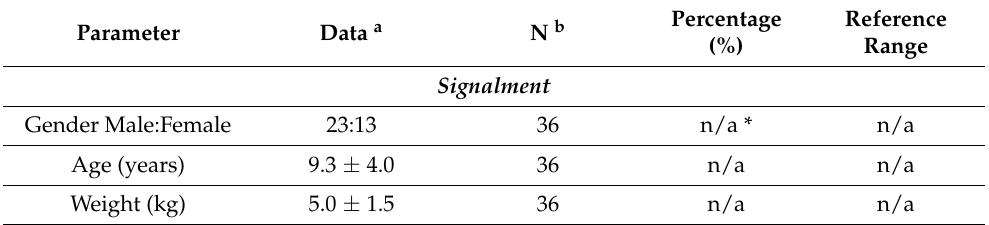
Table 1. Data from the 36 cats presenting with arterial